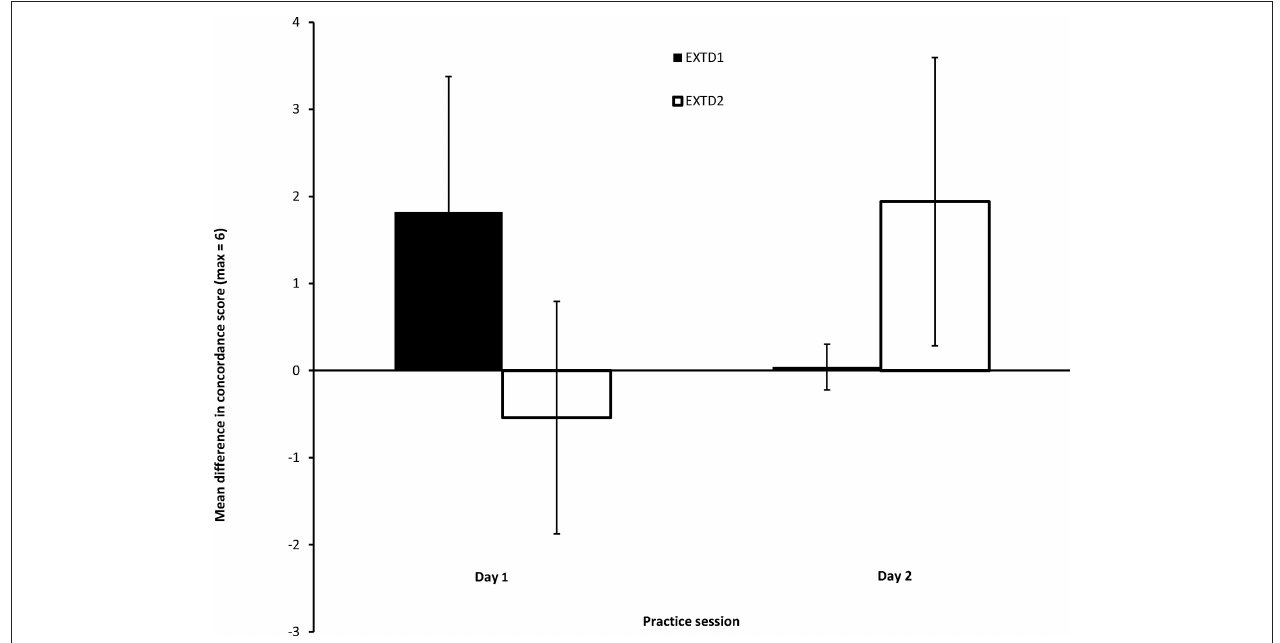
Figure 5 | Mean difference in instruction concordance scores for the two external instruction groups (exTD1 and exTD2) after day 1 and day 2 of